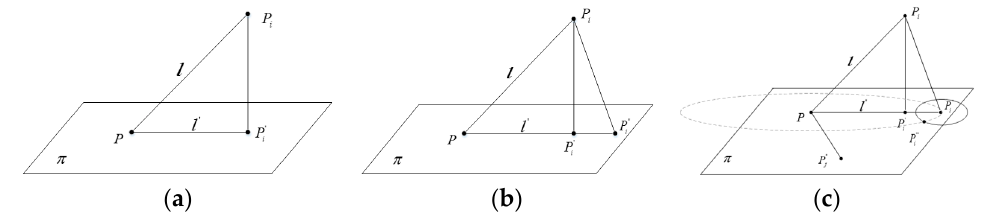
Figure 1. Projection approach with distance adjustment. ( a ) Direct projection; ( b ) First distance adjustment; ( c ) Second distance adjustment.